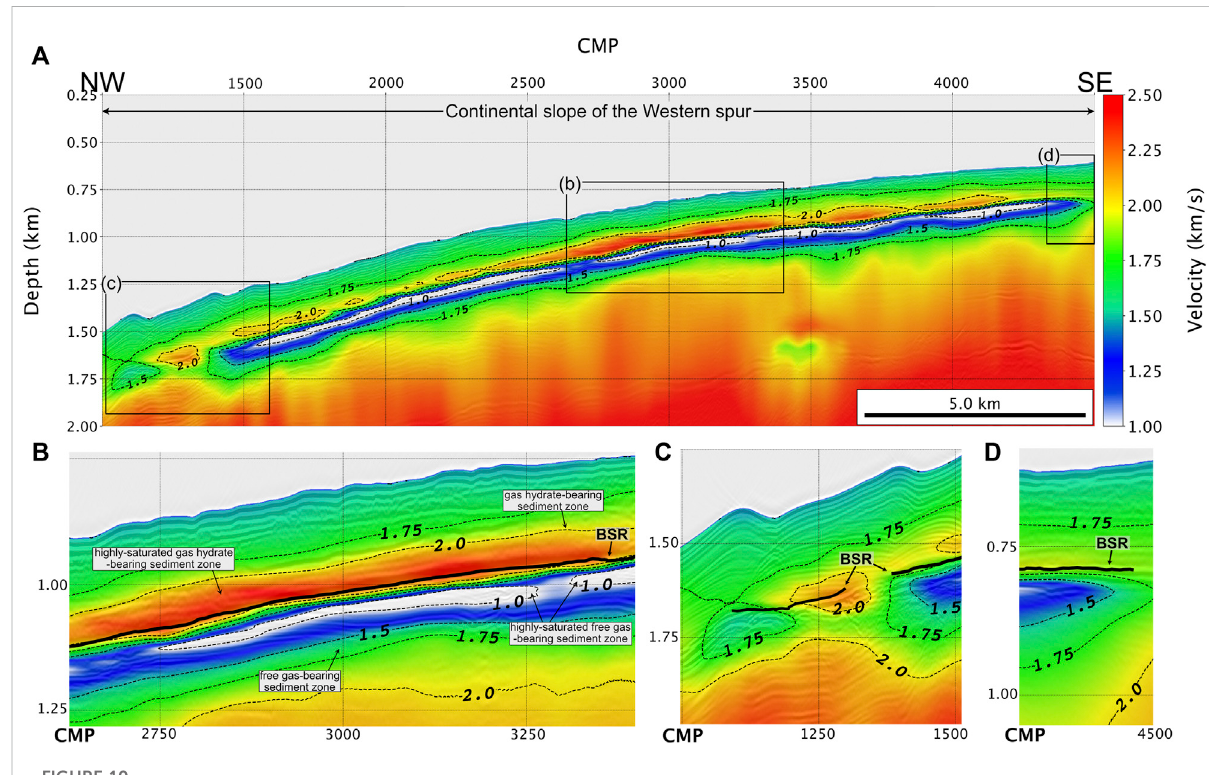
FIGURE 10 (A) Constructed P-wave velocity model overlaid with migrated seismic images using the IMVA of the MCS04 line. The analysis range is marked on thesolidred line inFigure 1C. (B) – (D) Enlarged velocity model: (B) continentalslope of thewestern spur, (C) deepest areashowingtheBSR ofthe western spur, and (D) shallower area showing the BSR of the western